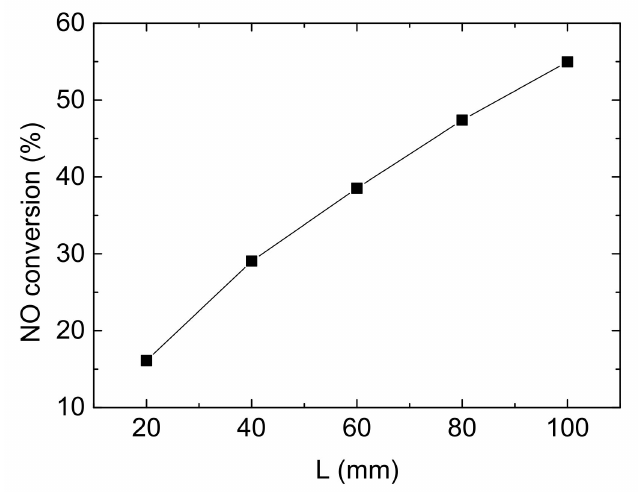
Figure 10. Influence of reactor length on NO conversion (Reaction temperature T = 150 ◦ C, Concen- tration C NH3 = C NO = 750 ppm, C O2 = 6%, without H 2